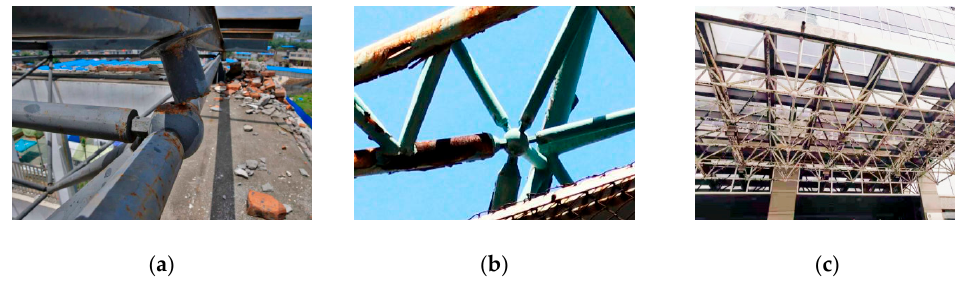
Figure 1. Corrosion cases for bolt-sphere joints: ( a ) Case 1; ( b ) Case 2; ( c ) Case 3.